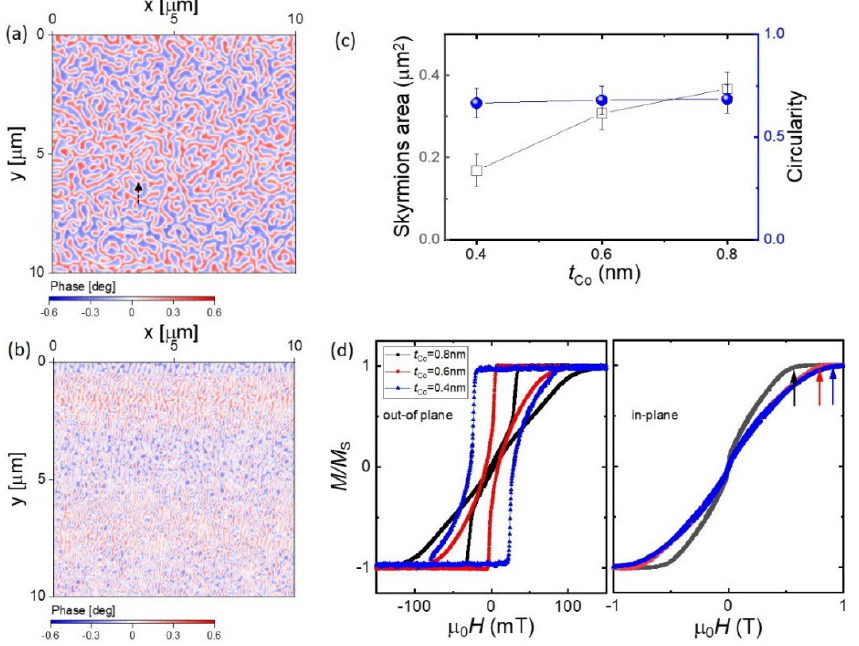
Figure 3. MFM and magnetisation measurements vs. Co thickness ( t Co ) at room temperature. The MFM images were acquired in the as-grown state for t Co = 0.6 nm ( a ) and t Co = 0.4 nm ( b ). ( c ) Plot showing the area of the skyrmions and the circularity vs. t Co at zero field after the “in-plane field procedure”. ( d ) Normalised hysteresis curves, M / M S vs. the external magnetic field µ 0 H , in both the out-of-plane (left) and in-plane (right) directions for t Co = 0.8 nm, t Co = 0.6 nm, and t Co = 0.4 nm. Arrows show the anisotropy field, which is obtained from the in-plane magnetisation curve at saturation.